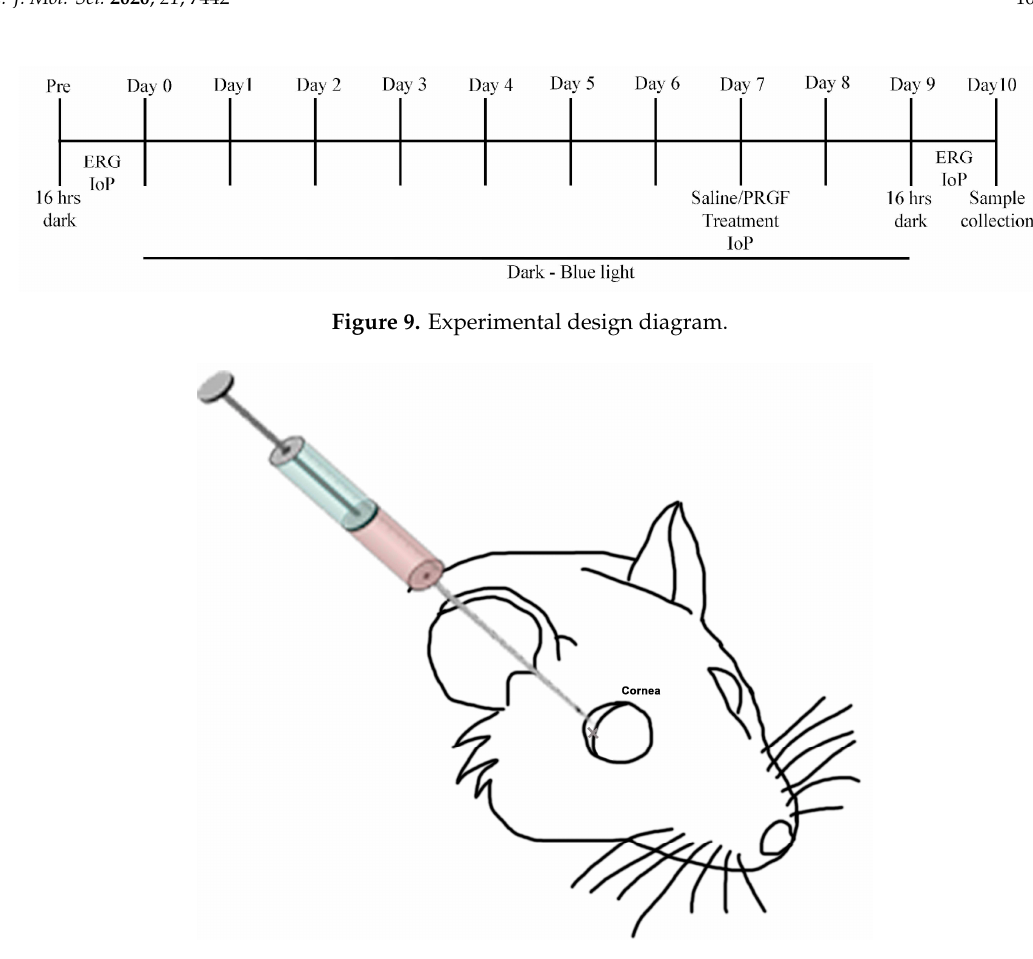
Figure 10. Diagram of eye injection.